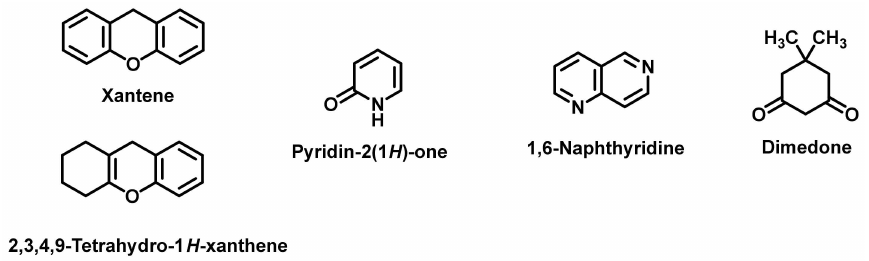
Figure 1. Pharmacophore fragments of biologically active